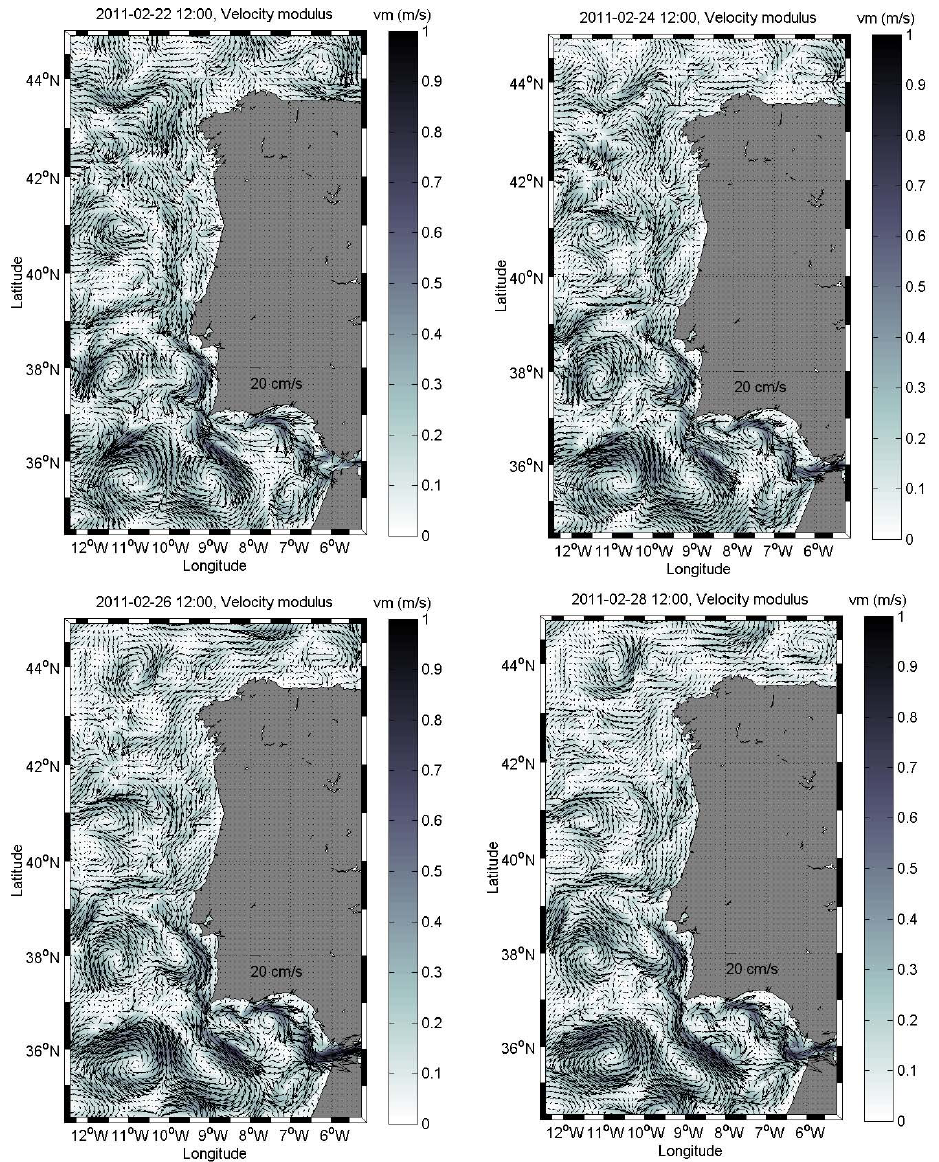
Fig. 4. Snapshots of sea surface current field predicted by the model from 22 to 28 February